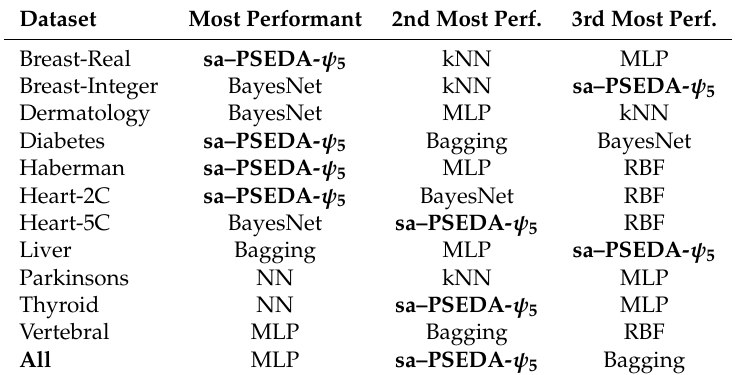
Table 7. Best classification methods (sa–PSEDA- ψ 5 plus 11 state-of-the-art algorithms). Dataset Most Performant 2nd Most Perf. 3rd Most